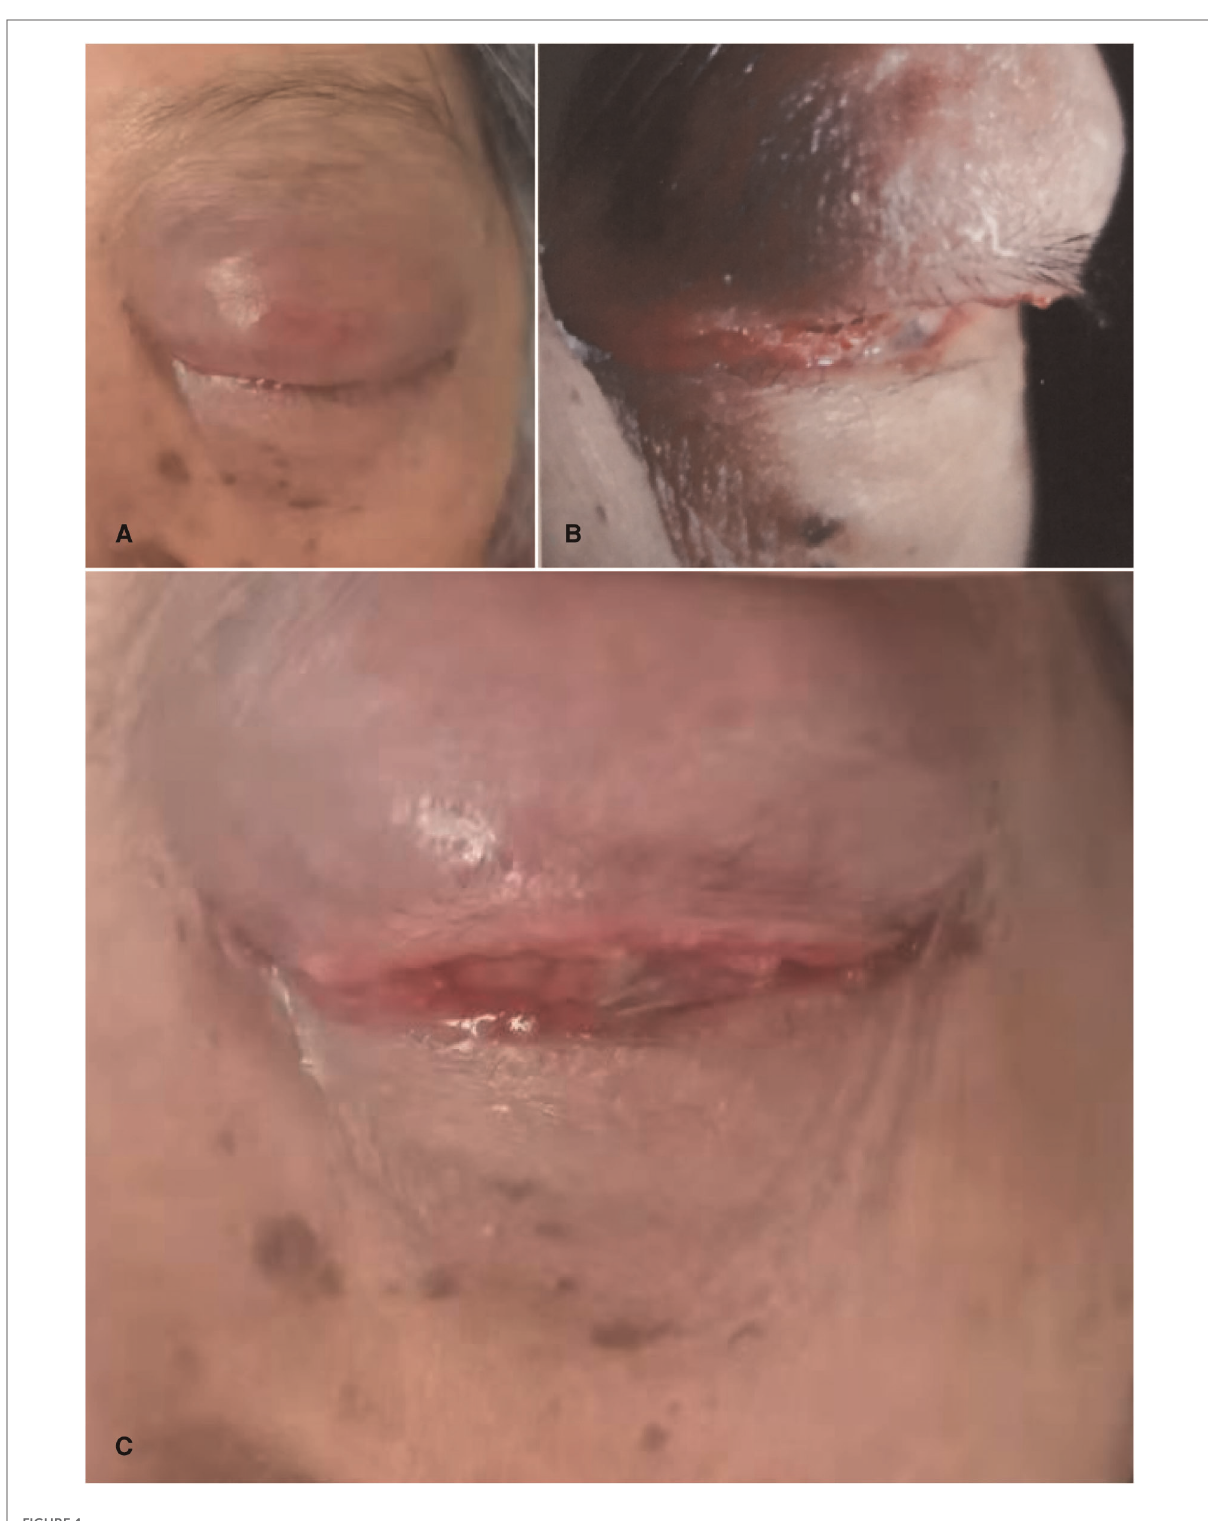
FIGURE 1 Ocular pathological features. ( A ) the patient ’ s left upper eyelid was red and swollen, the skin lines disappeared, and it was dif fi cult to open his eyes. ( B ) the patient ’ s upper eyelid can reach a size of about 30 mm×20 mm mass with unclear boundary, hard quality and poor activity. ( C ) the patient had bulbar conjunctival congestion, edema and corneal